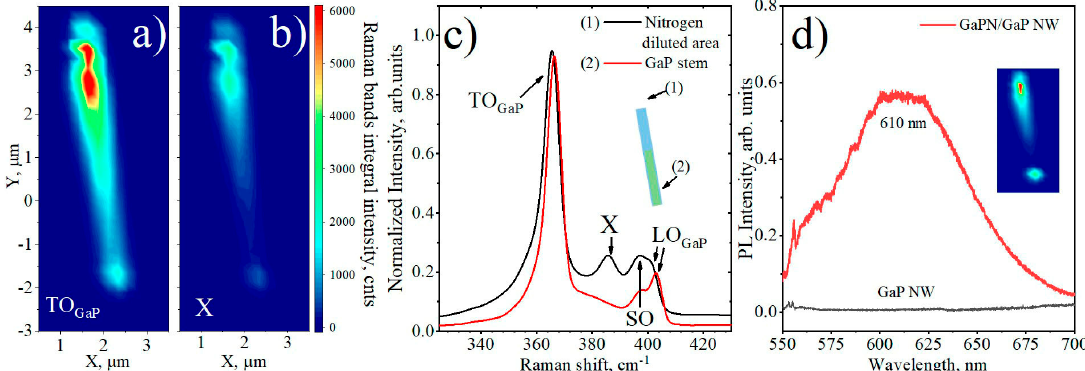
Figure 4. Raman spectroscopy mapping of individual exfoliated heterostructured GaPN / GaP NW transferred onto the glass substrate: spatial distribution of integrated scattering intensity of the ( a ) transverse optical (TO)-GaP and ( b ) GaPN-specific alloying X bands; ( c ) typical Raman spectra obtained at the top and the bottom part of NW (NW position schematically presented in the inset); ( d ) PL spectra taken from heterostructured GaPN / GaP and pure GaP NW, the inset is an integral PL intensity spatial map taken for the same GaPN / GaP